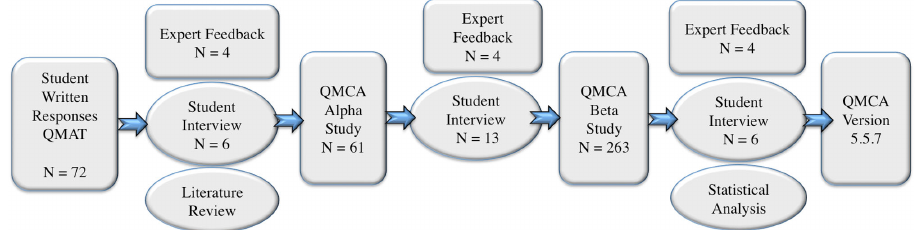
FIG. 1. A diagrammatic view of research and